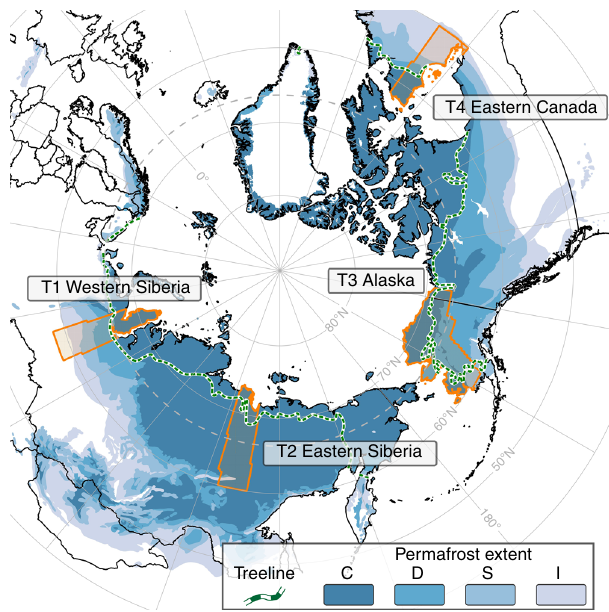
Fig. 1 Overview of study regions. Four continental-scale permafrost region disturbance (PRD) change detection study areas (orange polygons) overlain on a circumpolar permafrost extent map 20 and treeline delineation 19 . C: continuous permafrost, D: discontinuous permafrost, S: sporadic permafrost, I: isolated